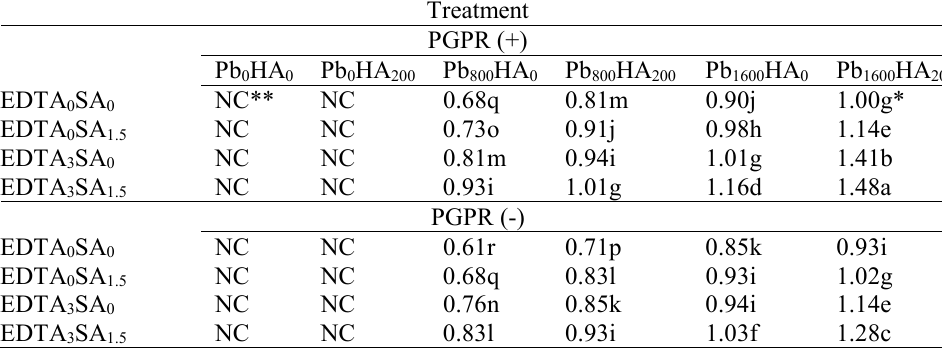
Table 5. Effect of treatments on Pb remediation efficiency